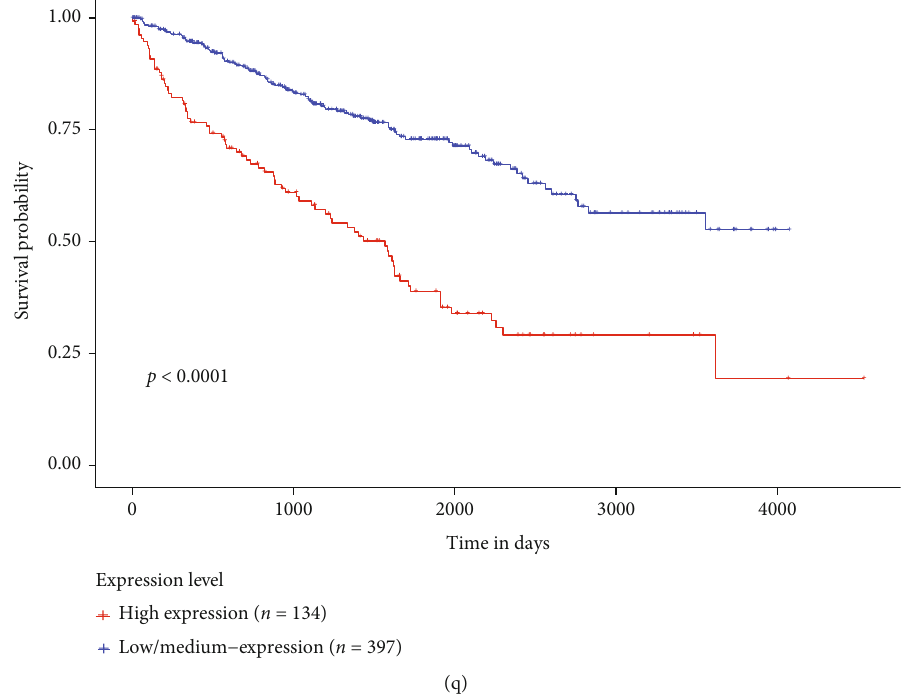
Figure 9: The expressions of genes used to construct IGRPM on the prognosis of KIRC. (a) OASL; (b) NR3C2; (c) THRB; (d) SAA1; (e) HNF4A; (f) SLC11A1; (g) SEMA6D; (h) CXCL5; (i) TLR3; (j) LGR4; (k) INHBE; (l) CSF1; (m) CLDN4; (n) PLA2G2A; (o) CRP; (p) TNFSF14; (q)